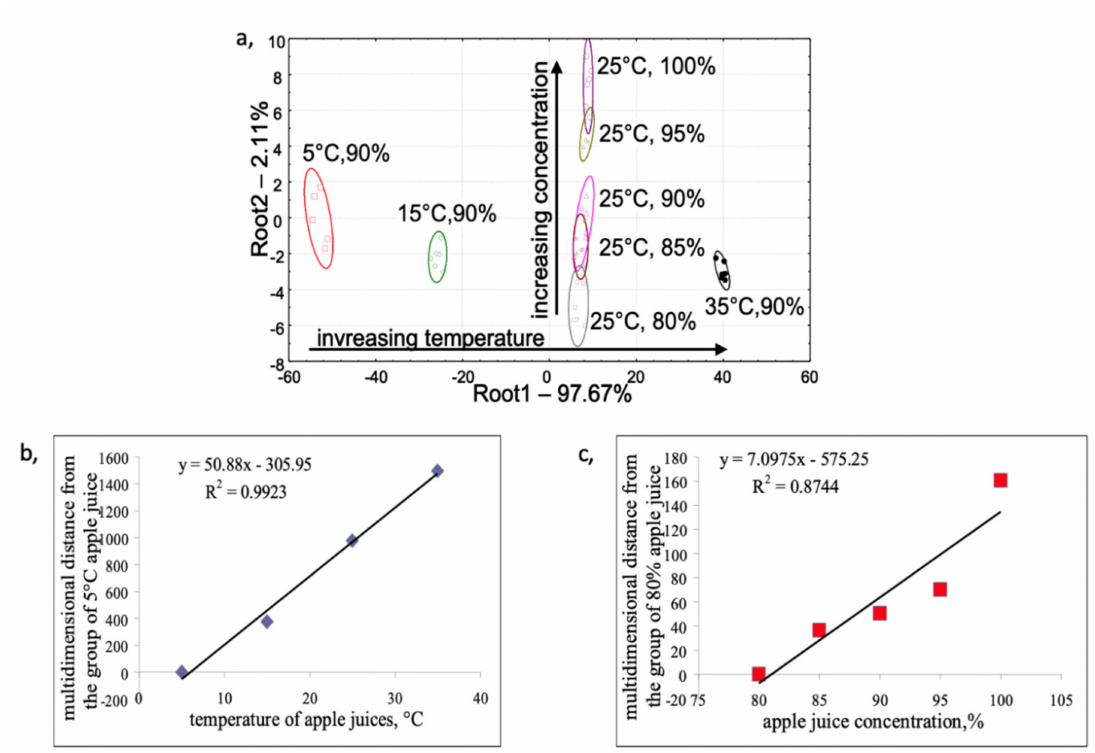
Figure 2. ( a ) Discriminant analysis score plot of the di ff erent concentrations of apple juice at di ff erent temperatures and ( b ) the Euclidian multidimensional distance between the groups of apple juices with di ff erent concentrations and ( c ) with di ff erent temperatures with the fitted regression